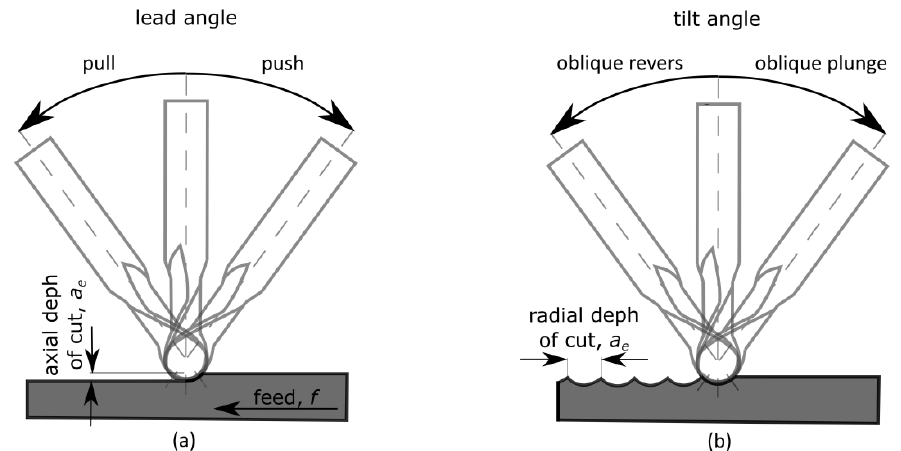
Figure 1. Tool inclination in the feed direction ( a ) and perpendicular to the feed direction ( b ).